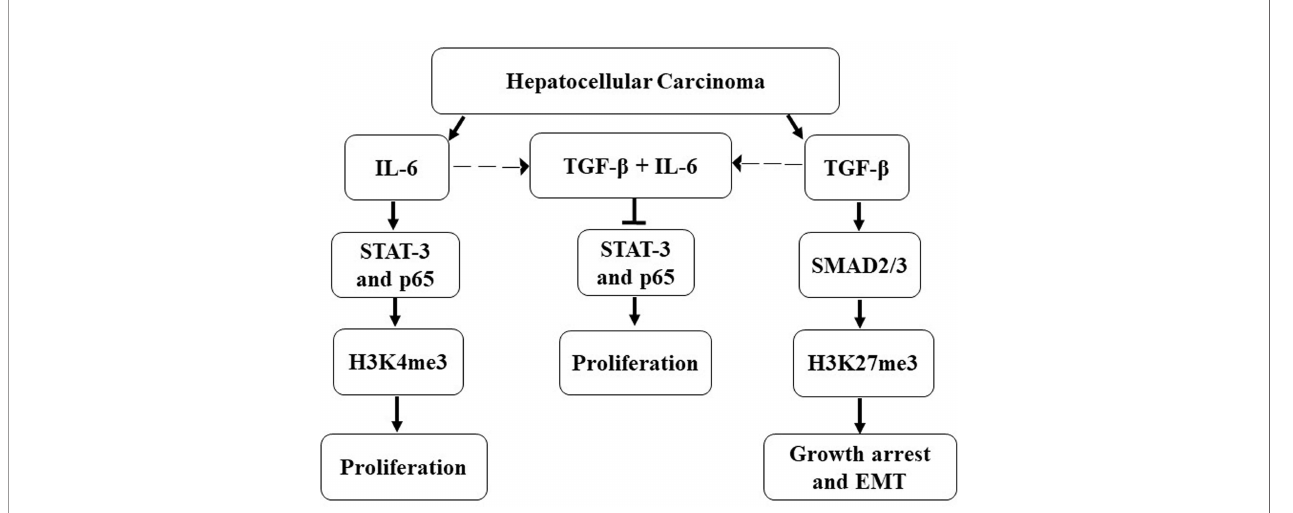
FIGURE 9 | Schematic representation of crosstalk between IL-6 and TGF- b